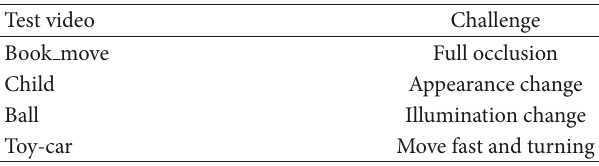
Table 3: Descriptions for the selected